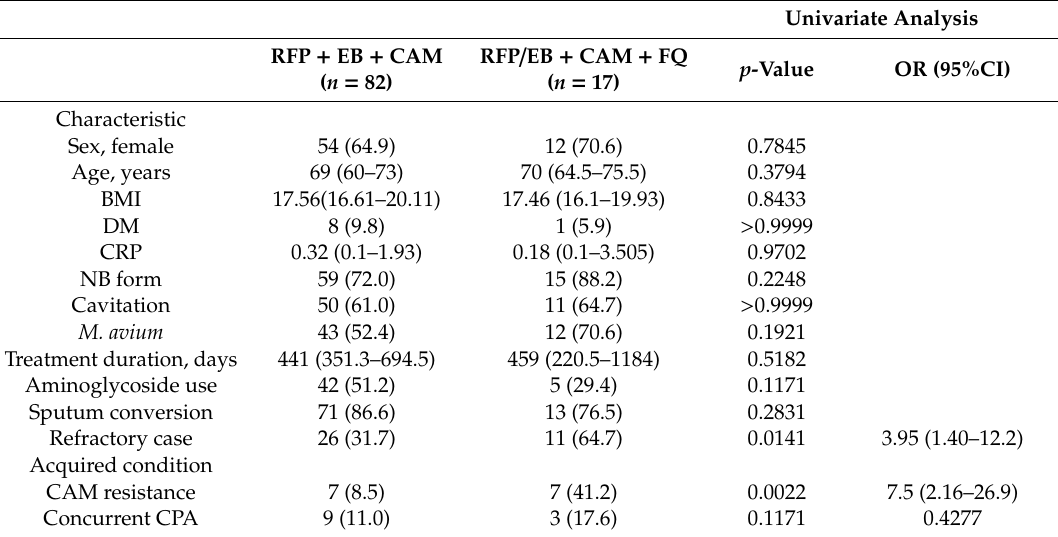
Table 4. Comparison of RFP + EB + CAM and RFP / EB + CAM + FQ